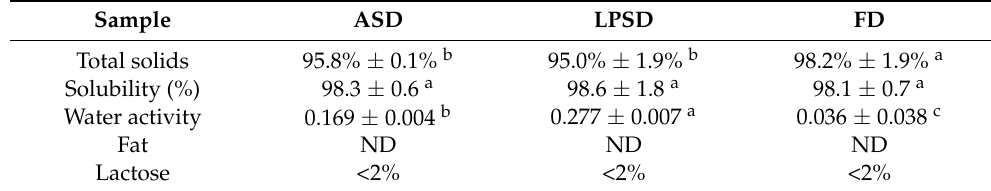
Table 1. Basic characteristics of serum protein powder manufactured by ASD, LPSD and